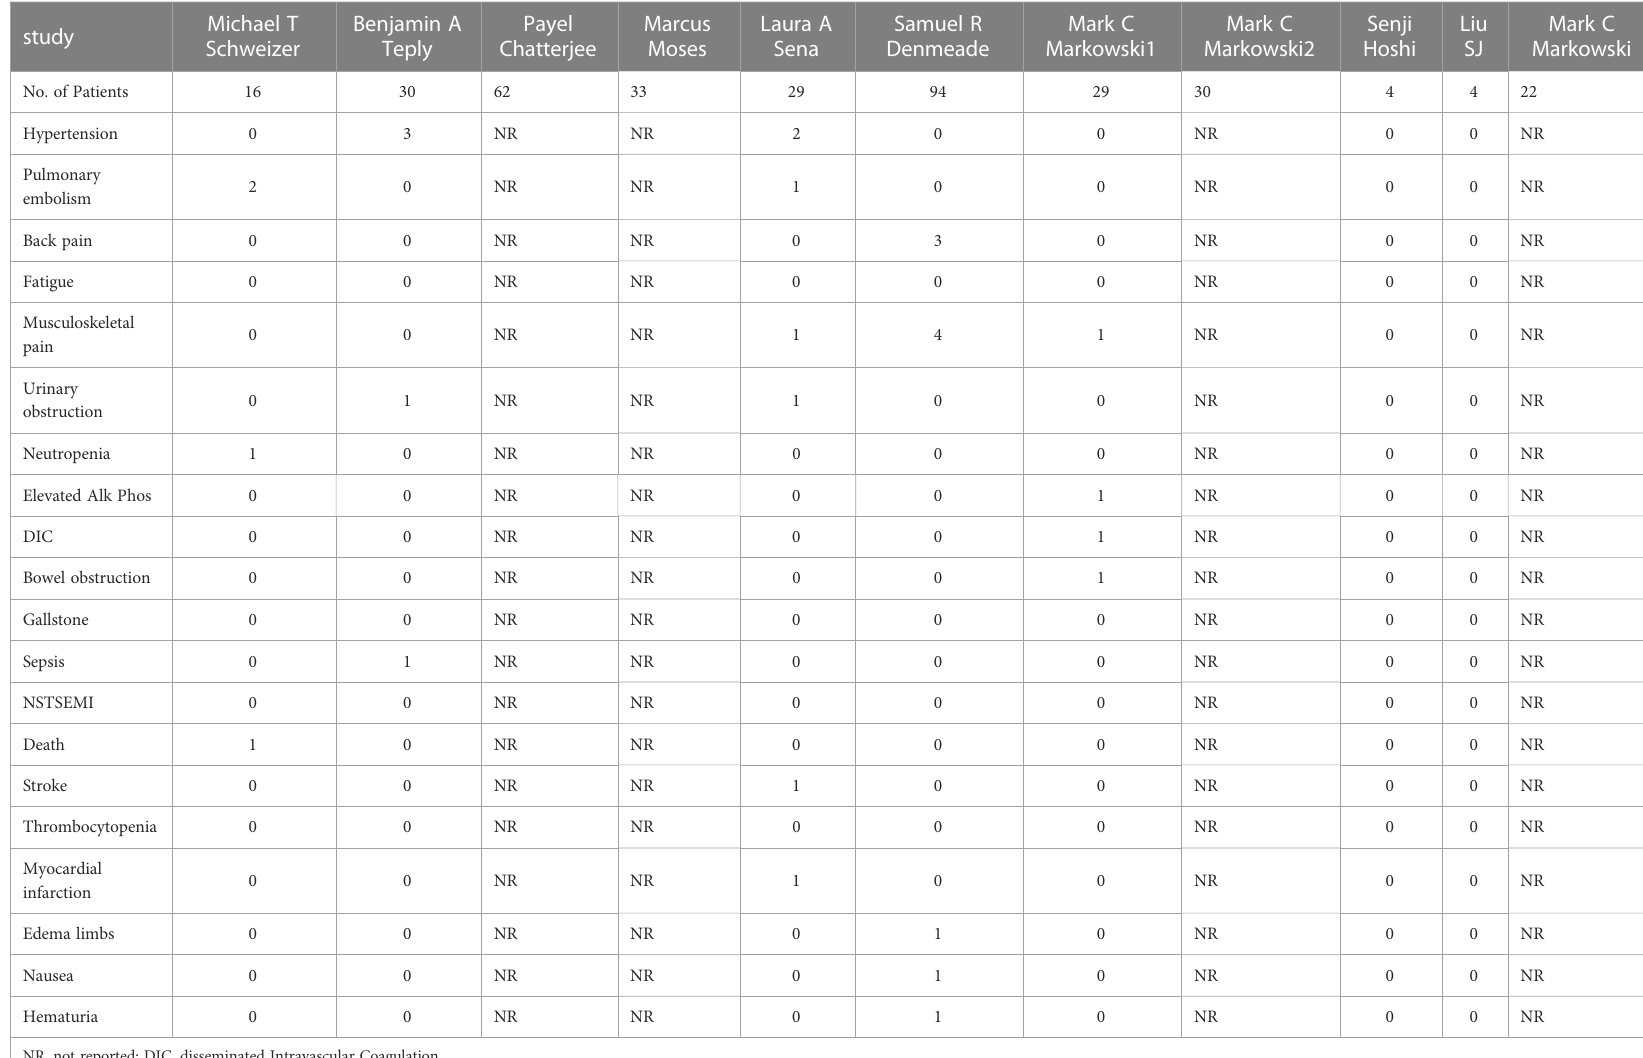
TABLE 3 AEs (Grade ≥ 3) adverse events in included studies.